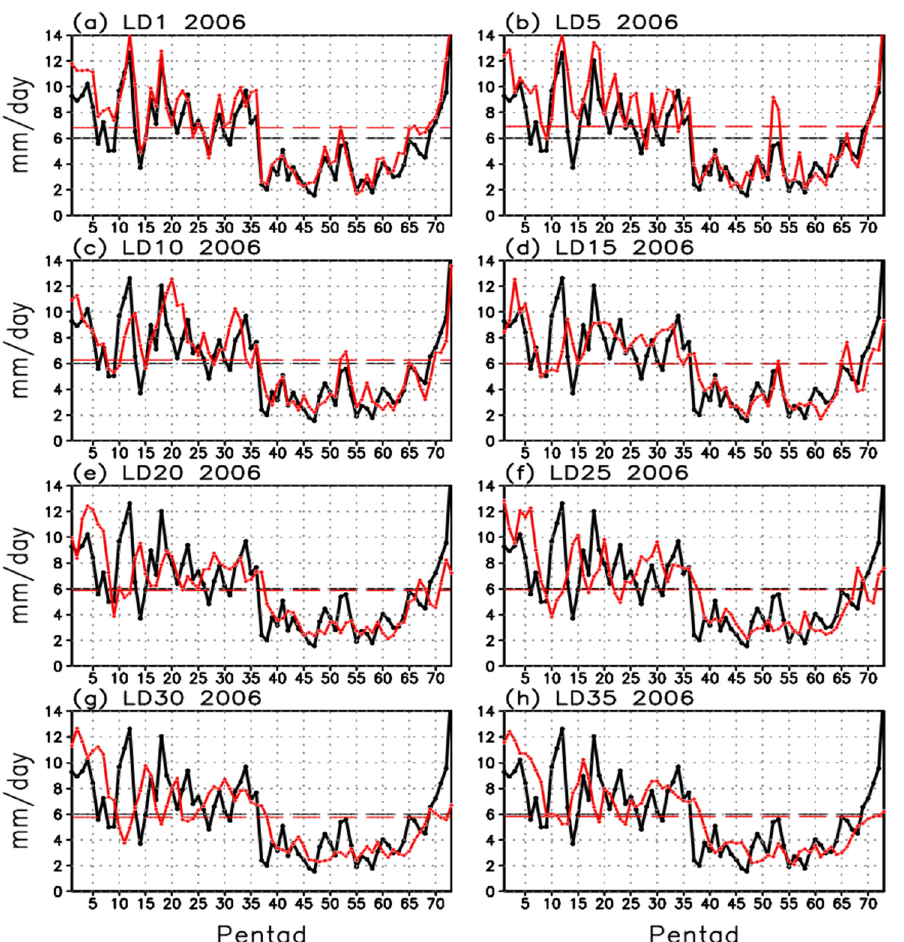
Figure 14. Pentad mean rainfall (mm/day) averaged over the Maritime Continent in 2006 for observation (GPCP; black line) and CFSv2 predictions (red line) in ( a ) LD1; ( b ) LD5; ( c ) LD10; ( d ) LD15; ( e ) LD20; ( f ) LD25; ( g ) LD30; and ( h ) LD35.